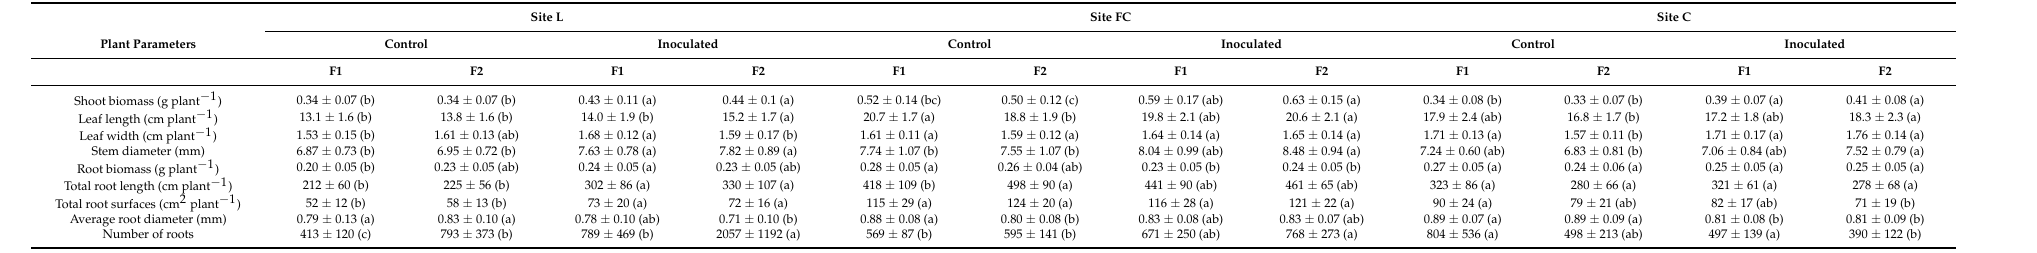
Table 1. Effect of inoculum level of Azospirillum lipoferum CRT1 on root and shoot parameters of maize grown at the three fields sites L (Chatonnay), FC (S é r é zin-la- Tour) and C (Saint Savin). Formulation F1 corresponds to the peat matrix used to coat seeds with low inoculant concentration, and the corresponding data in this table originate from [21]. In formulation F2, A. lipoferum CRT1 was used at higher inoculant concentration. Stem diameter was measured at root collar level and foliar morphology on leaf number five. At each field site, statistical differences between the four treatments are indicated by letters a–c (ANOVA and Fischer’s LSD tests, p <